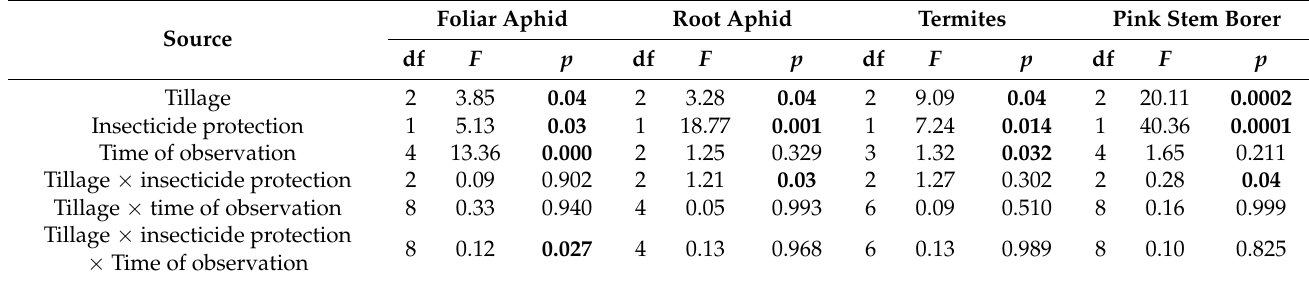
Table 2. Split-plot ANOVA for foliar aphids (per tiller), root aphid (per tiller), termite damage (%), and pink stem borer damage with tillage, insecticide protection, and time of observation as factors during 2016–2017 and 2017–2018 (pooled) (significance: p ≤ 0.05 are bolded).